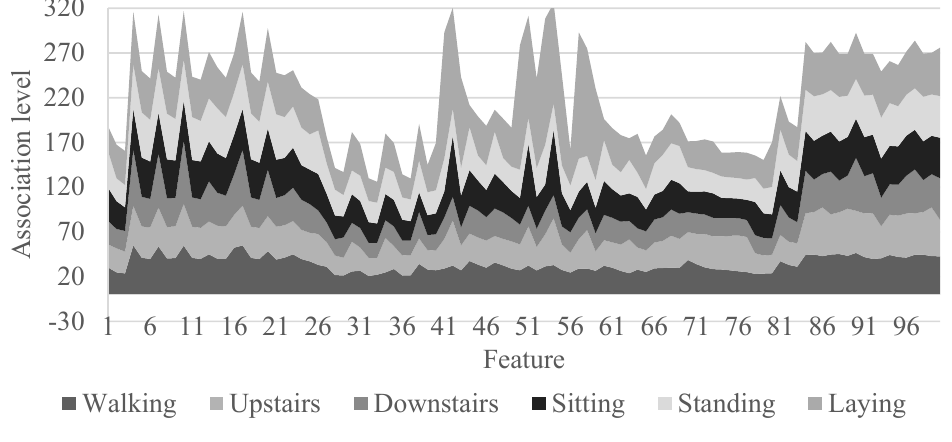
Figure 5. Association level of each activity for the 100 first